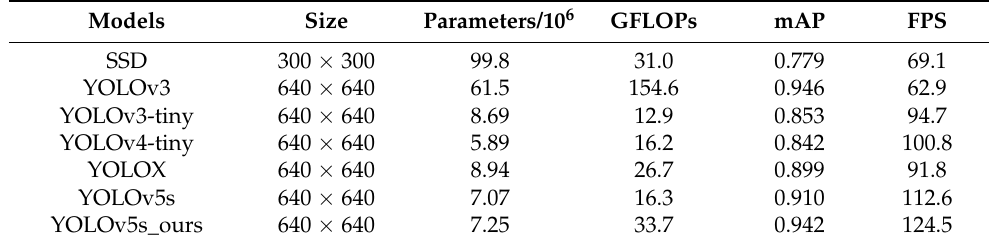
Table 4. Performance comparison of target detection